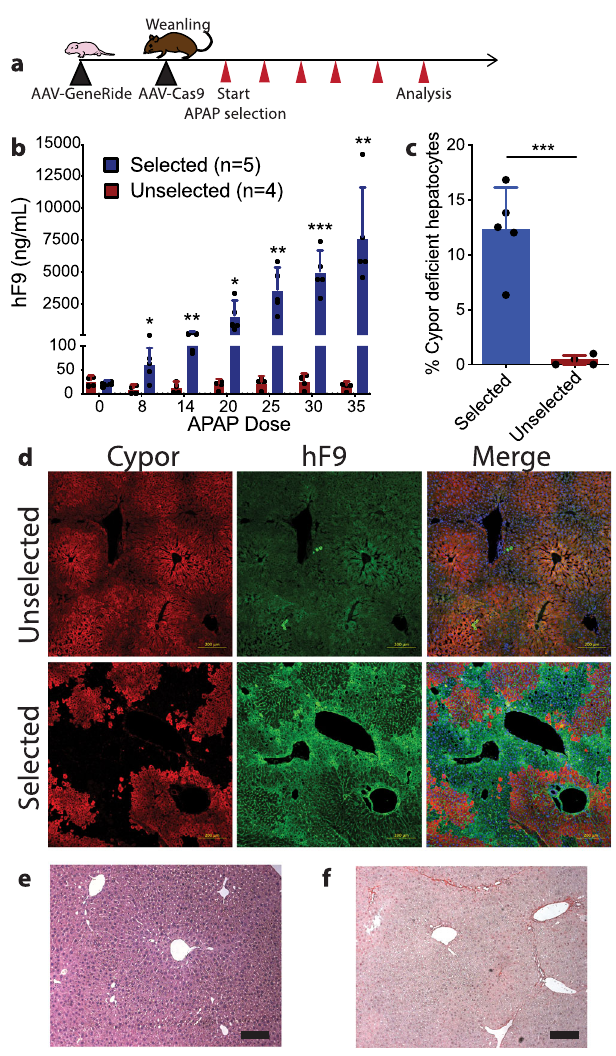
Fig. 2 | Expansion of hepatocytes with integration of GR-Cypor scgRNA by acetaminophen. a Schematic of the experimental timeline. The GR- Cypor scgRNA rAAV vectorcontaining ahF9transgene and Cypor scgRNAwith arms of homology totheAlbuminlocuswasdeliveredtoneonatalWTmice.Atweaning,themicewere given rAAV-spCas9 and biweekly APAP administration was started. Mice were bled for hF9 concentration following every 5th dose of APAP administered. b hF9 con- centrations in mice that were selected with APAP compared to unselected mice. Biologically independent mice were analyzed. Data are presented as mean values and error bars represent standard deviation (Dose 8 p =0.015; Dose14 p =0.008; Dose 20 p =0.039; Dose 25 p =0.0051; Dose 30 p =0.0006; Dose 35 p =0.006). c Quanti fi cation of Cypor de fi cient hepatocytes by indel frequency following terminalharvest.Biologicallyindependentmicewereanalyzed.Dataarepresented as mean values and error bars represent standard deviation ( p =0.0005). Selected n =5 animals; No selection n =4 animals. d Representative immuno fl uorescent stainingagainstCyporandhF9intheliverofunselectedmice(noAPAPtreatment) and selected mice (received APAP treatment) at terminal harvest. Scale bars represent200 µ m. e HematoxylinandeosinstainingofaliversectionfromanAPAP selected mouse. Scale bars represent 100 µ m. n =5 mice. f Picro Sirius red staining in an APAP selected mouse. The presence of red staining fi bers would indicate fi brosis within the liver. Scale bars represent 100 µ m. n =5 mice. Statistics were calculated using a two-sided unpaired t test. * P <0.05, ** P <0.01 and *** P <0.001. Source data are provided as a Source Data fi